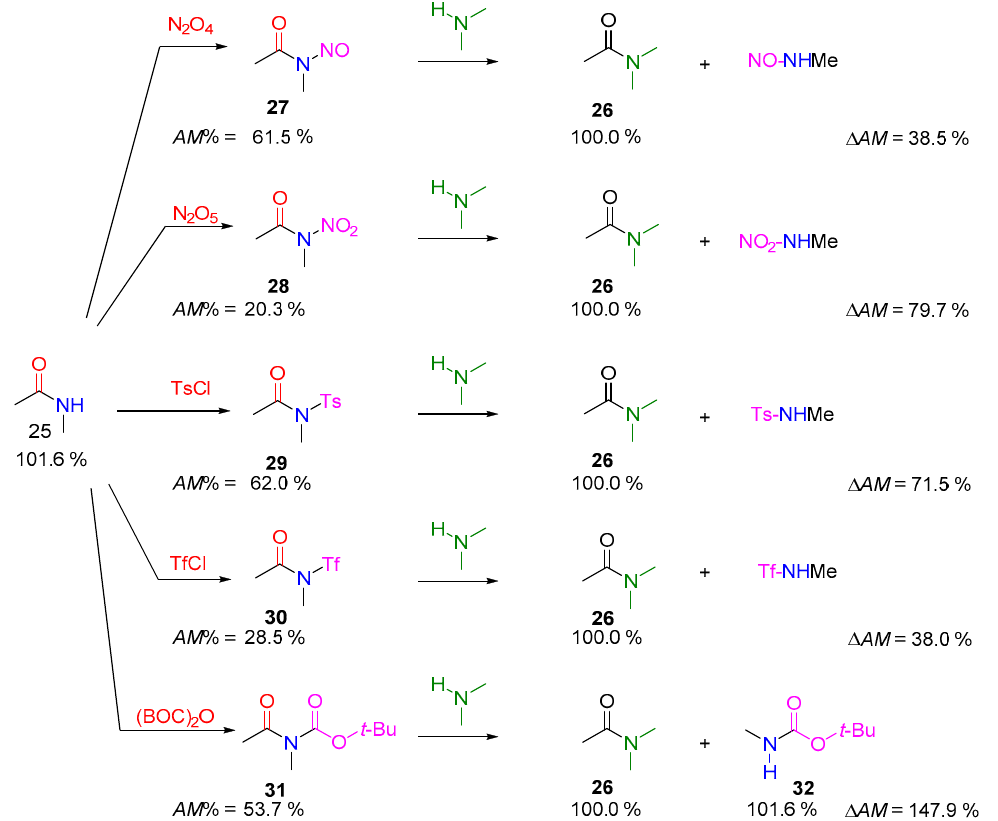
Figure 12. Some representative examples of amide activations (case III), using various reagents with the corresponding amidicity values computed at B3LYP/6-31G(d,p) level of theory. Ts = p -toluenesulfonyl; Tf = CF 3 SO 2 –; BOC = t –BuO–CO–.